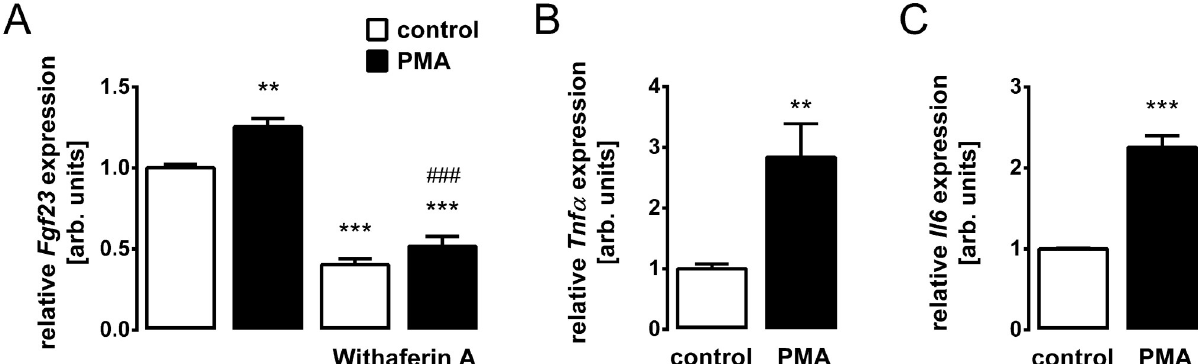
Fig 5. The PKC effect on Fgf23 gene expression is dependent on inflammation. Relative Fgf23 transcript levels in UMR106 cells incubated without or with PMA (0.1 μ M) in the absence and presence of NF κ B inhibitor Withaferin A (0.5 μ M) ( A ). Relative Tnf α ( B ) and Il6 ( C ) transcript levels in UMR106 cells incubated without or with PMA (0.1 μ M). Gene expression was normalized to Tbp as a housekeeping gene, and the values are expressed as arithmetic means ± SEM (n = 6). �� p < 0.01, and ��� p < 0.001 indicate significant difference from vehicle (first bar). ### p < 0.001 indicates significant difference from the absence of withaferin A (second bar vs. fourth bar). arb., arbitrary.